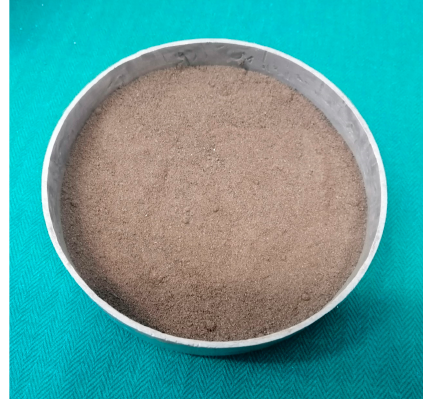
Figure 1. Sandy loam soil .